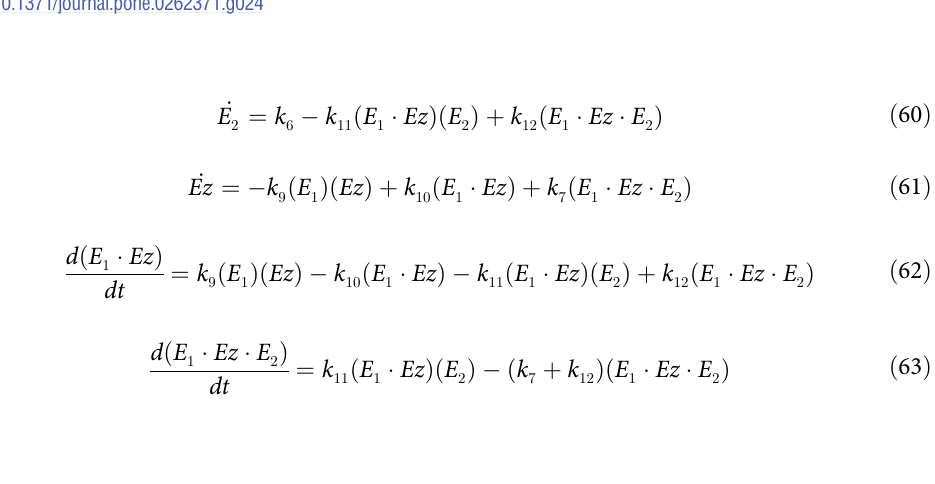
Fig 24. Reaction schemes when E 1 and E 2 in a m4-type of control structure (Fig 3) are removed by enzyme Ez with two compulsory-order ternary-complex mechanism. In (a) E 1 binds first to Ez , while in (b) E 2 binds first.